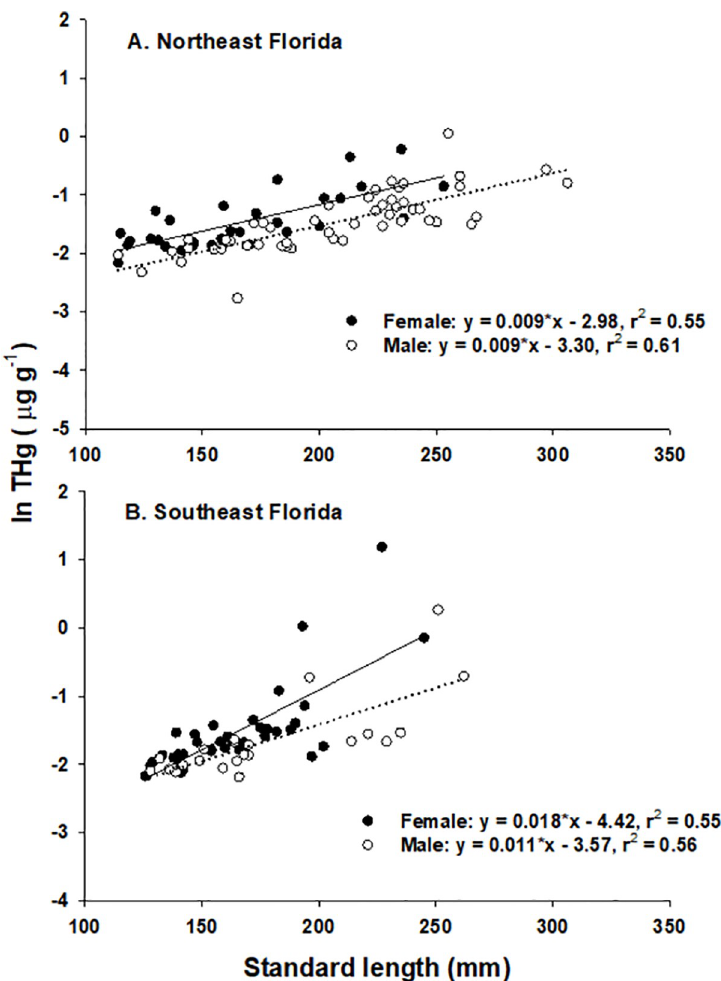
Fig 2. Relationships between lionfish and THg concentration by sex. Linear regression relationships between size (Standard length) and total mercury concentration for female (solid circles, solid line) and male (open circles, dotted line) lionfish in northeast Florida (A) and southeast Florida